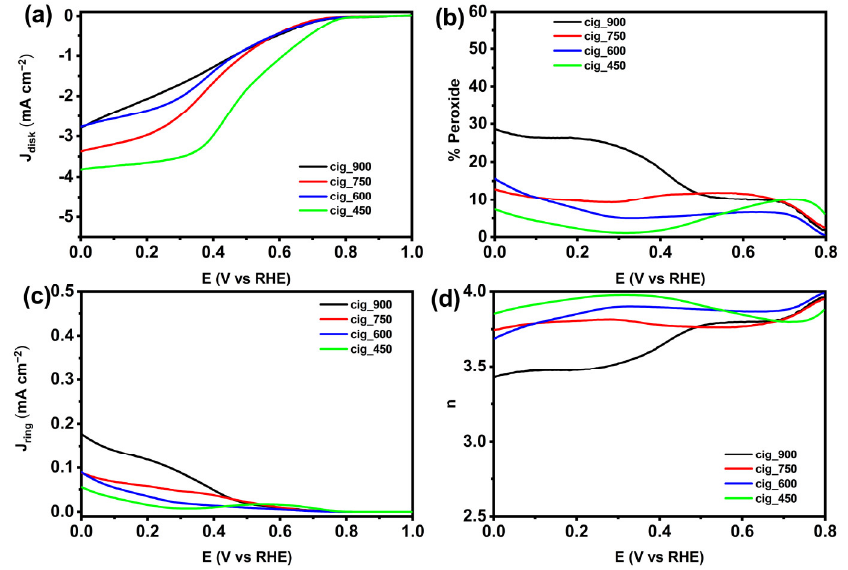
Figure 7. RRDE results of samples in neutral media: ( a ) Disk current density (J disk ) and ( c ) Ring current density (J ring ) recorded at 1600 rpm and 5 mV s − 1 , ( b ) % Peroxide and ( d ) the number of transferred electrons (n).